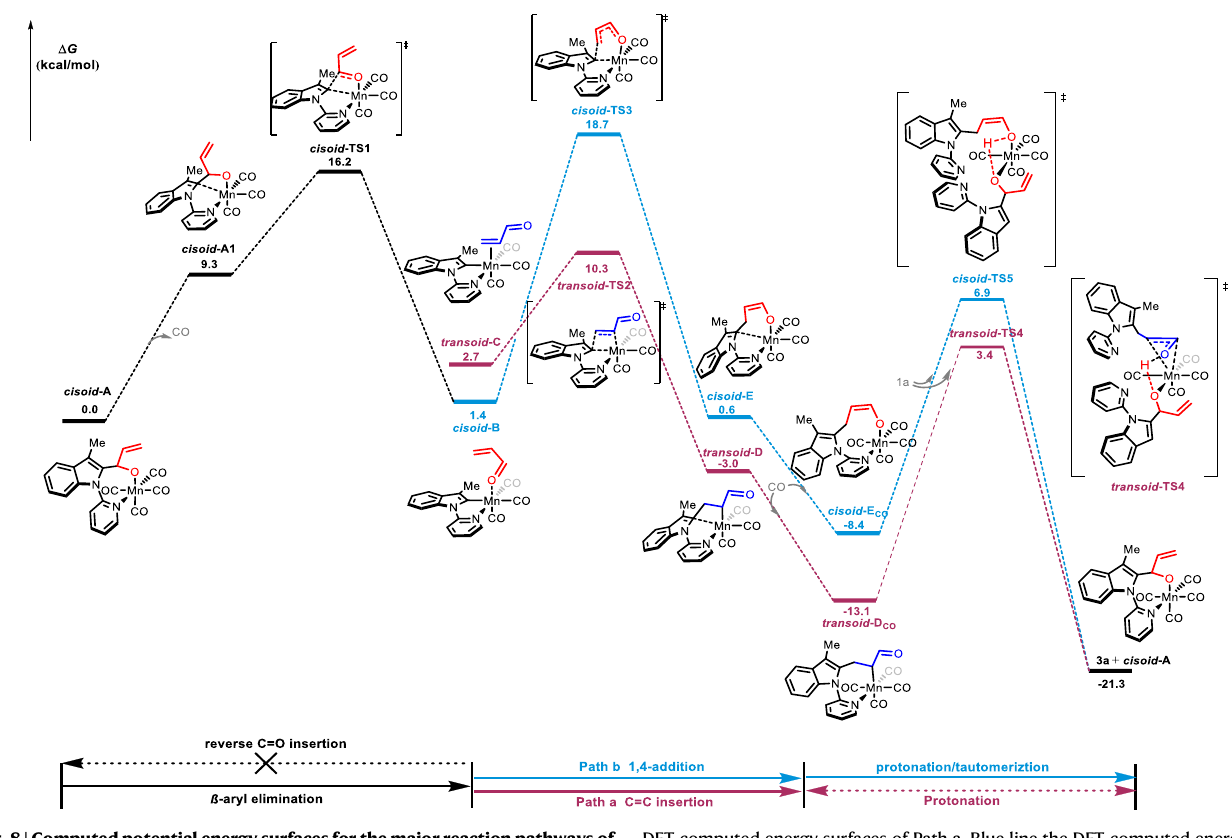
DFT-computed energy surfaces of Path a. Blue line the